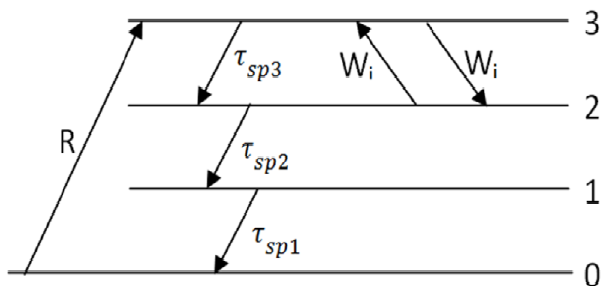
Figure 9. The energy model of a four level